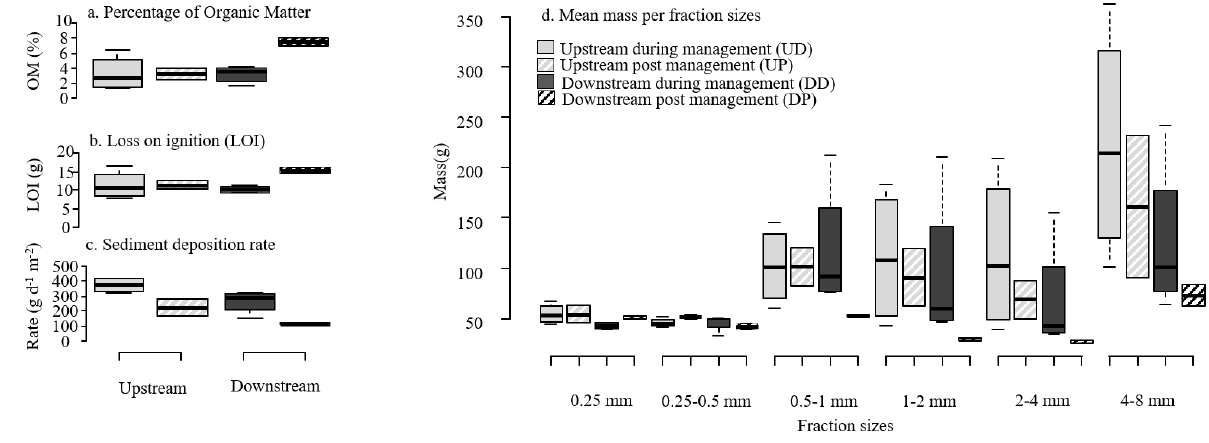
Figure 5. Distributions of a) OM (fractions 0–4 mm only), b) loss on ignition (LOI; fraction 0–4 mm only), c) sediment deposition rates and d) mean mass per fraction size in sediment baskets located in the Dyke river bed at sites upstream (light grey) and downstream (black) of restoration work. The two pairs of sediment baskets at each site were retrieved, emptied and replaced during (two collections) and after (one collection, hashed boxes) restoration management activities (see Figure